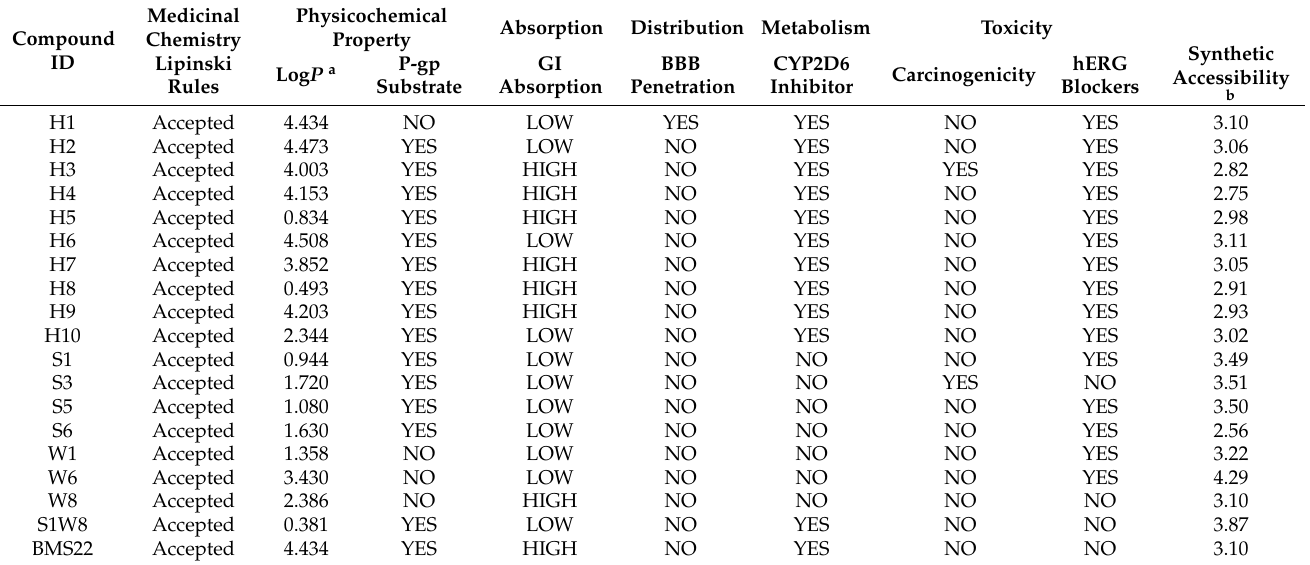
Table 1. ADMET properties of the designed